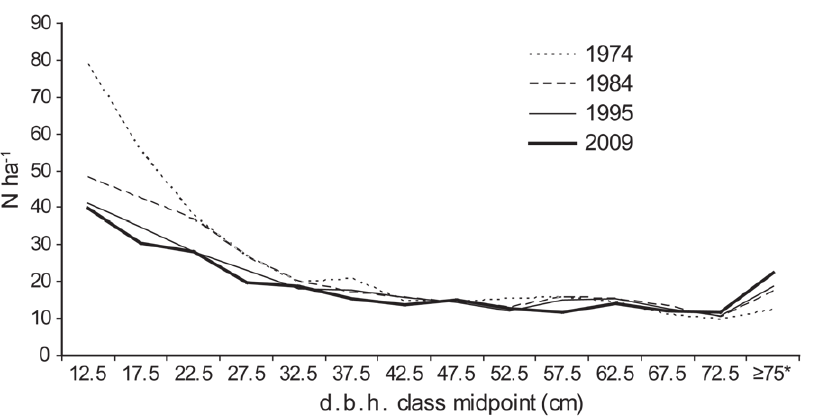
Figure 7. Diameter distribution (frequency of trees per 5-cm diameter classes) of all trees in the Gorjanci forest reserve. Note that all trees with d.b.h. $ 75 cm were classified in one 5-cm d.b.h. class (*).